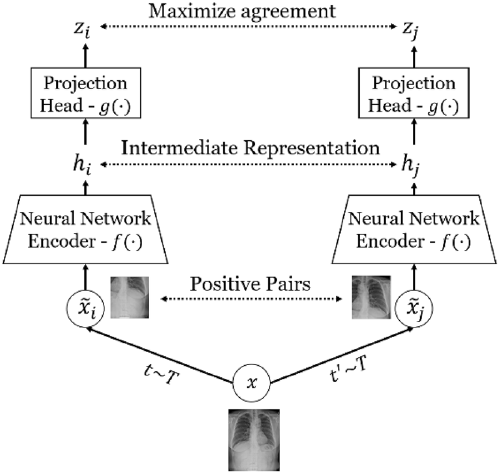
Figure 2. The SimCLR framework 32 . t ~ T and t’ ~ T are two independent data augmentation operators sampled from the predefined family of augmentations. A pair of samples (